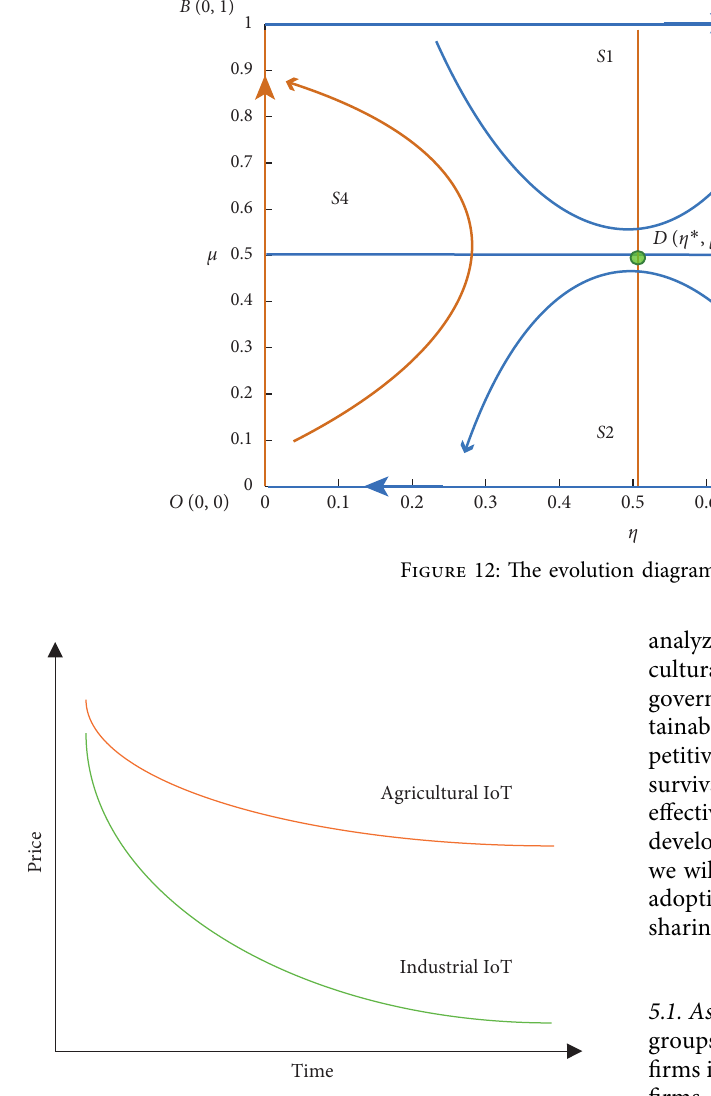
Figure 13: The price trends of IoT devices in industry and agriculture.